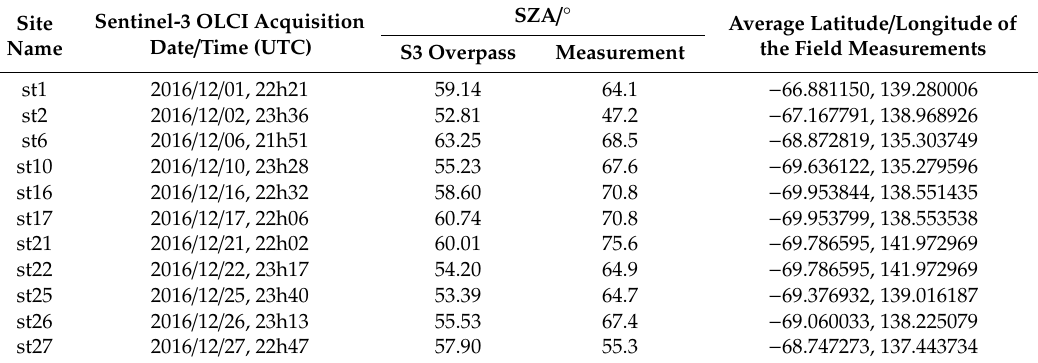
Table 2. Location, Sentinel-3 acquisition dates and times, and SZA values for the sites along the ASUMA traverse used for the validation of the spectral albedo products.